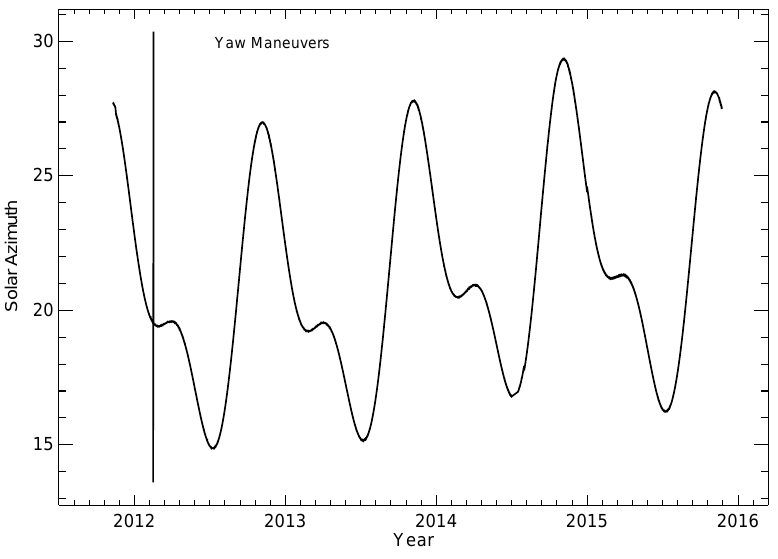
Figure 4. SNPP VIIRS solar-azimuth angle. The vertical line indicates the yaw maneuvers.